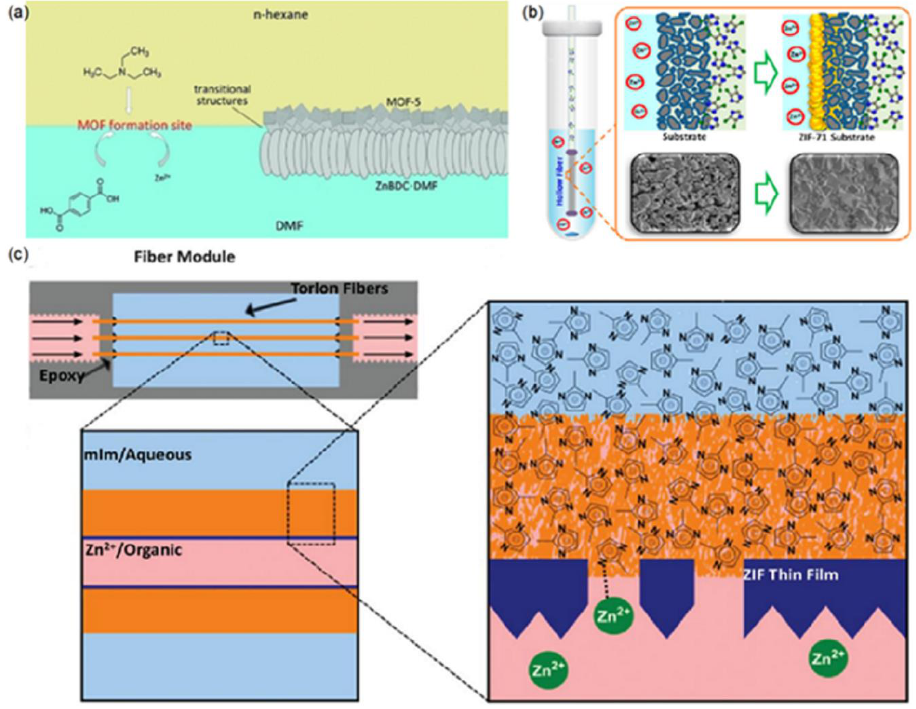
Figure 3. Schematic representations of the interfacial synthesis of MOF membranes ( a ) interfacial diffusion synthesis [64], ( b ) contra-diffusion and ( c ) dynamic interfacial synthesis. Reprinted with permissions with Refs.